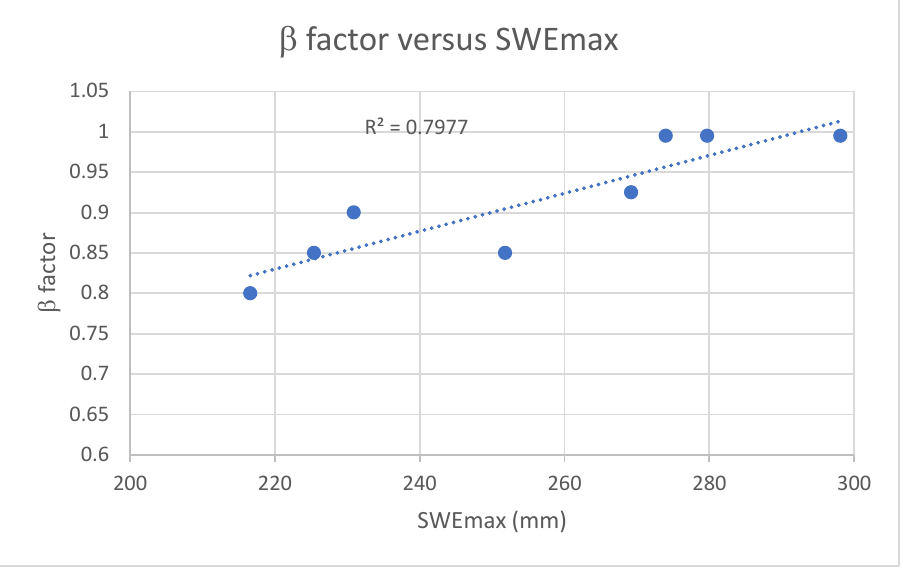
Figure 8. Scatterplot of the optimum versus in situ SWE max.